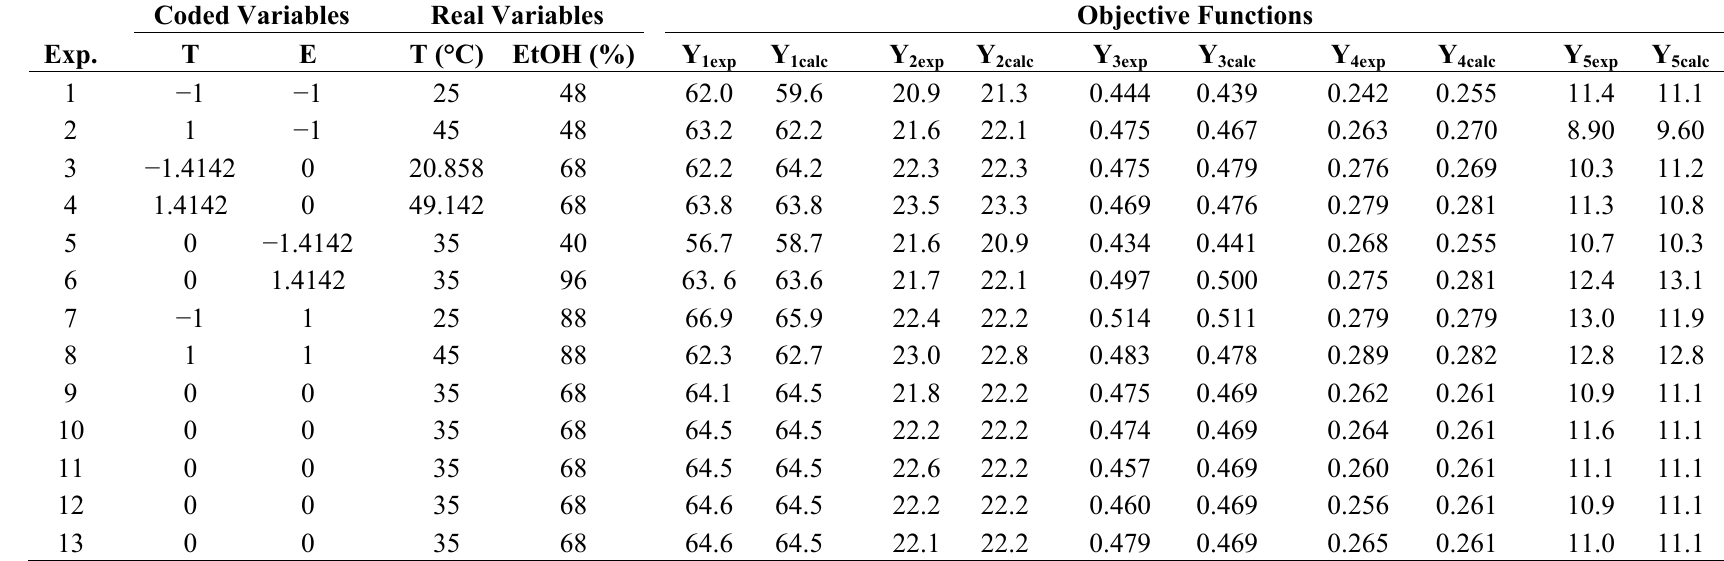
Table 2. Coded and real variables of a central composite design for two factors and experimental and calculated values of the objective functions during operation with Diaion